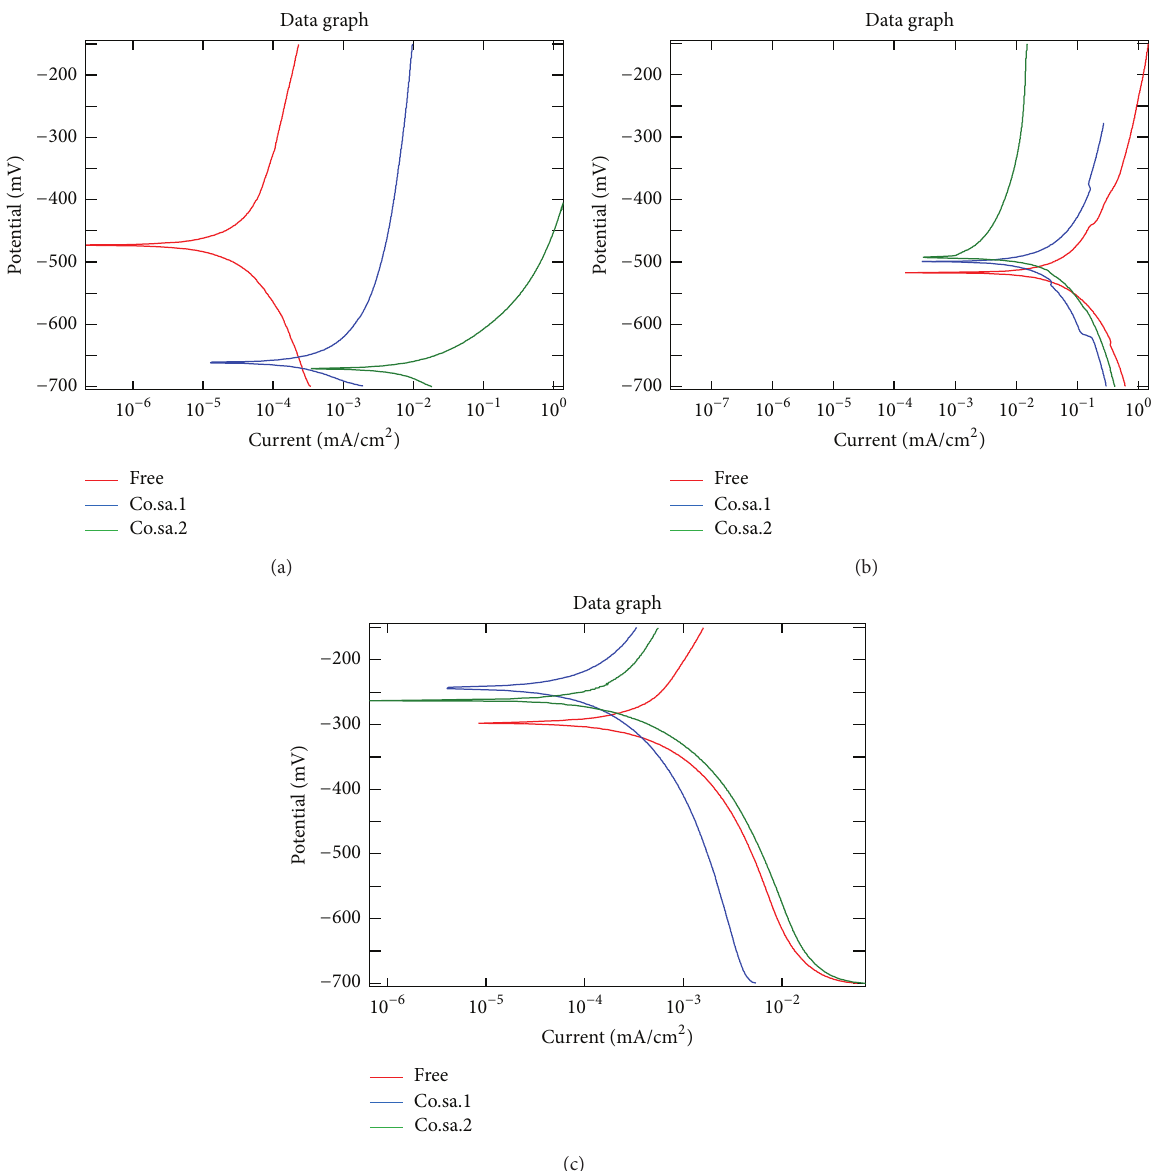
Figure 4: Comparison of the anticorrosion zeolite coatings produced by the in situ crystallization and the dry-gel-conversion processes in (a) 3% NaCl solution; (b) 0.1M H 2 SO 4 ; and (c) 0.1M NaOH